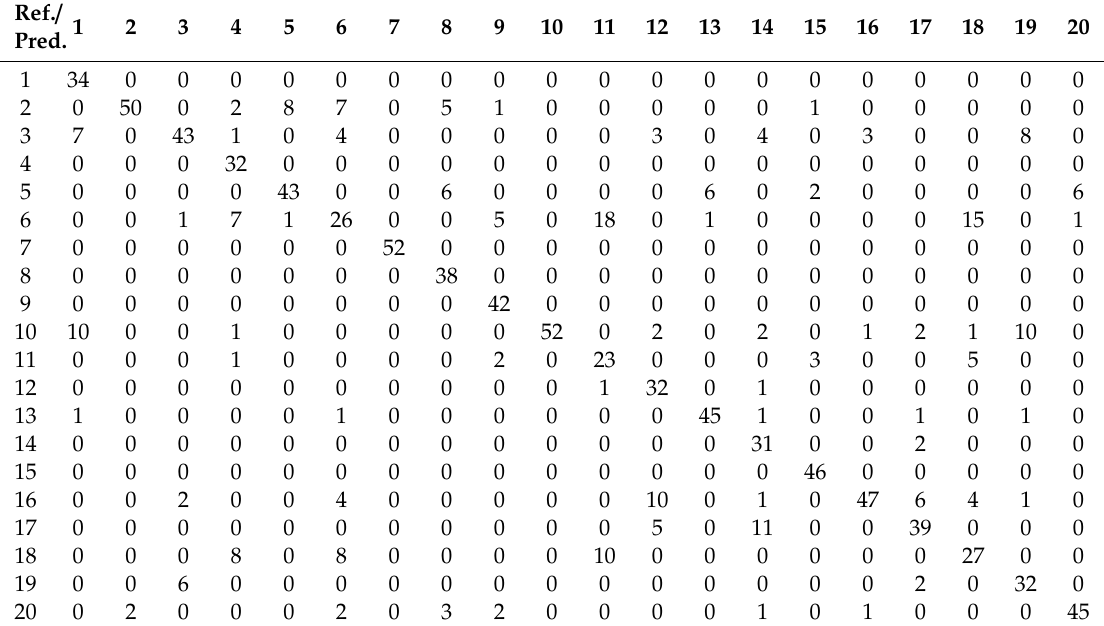
Table 5. Confusion matrix using the SVM classifier with RBF kernel.